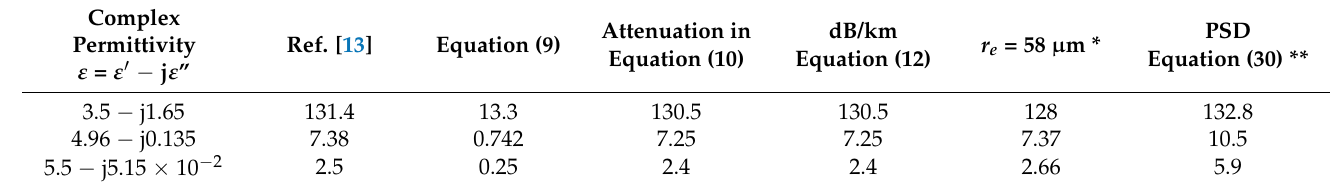
Table 5. Attenuation dB/km models comparison for different complex